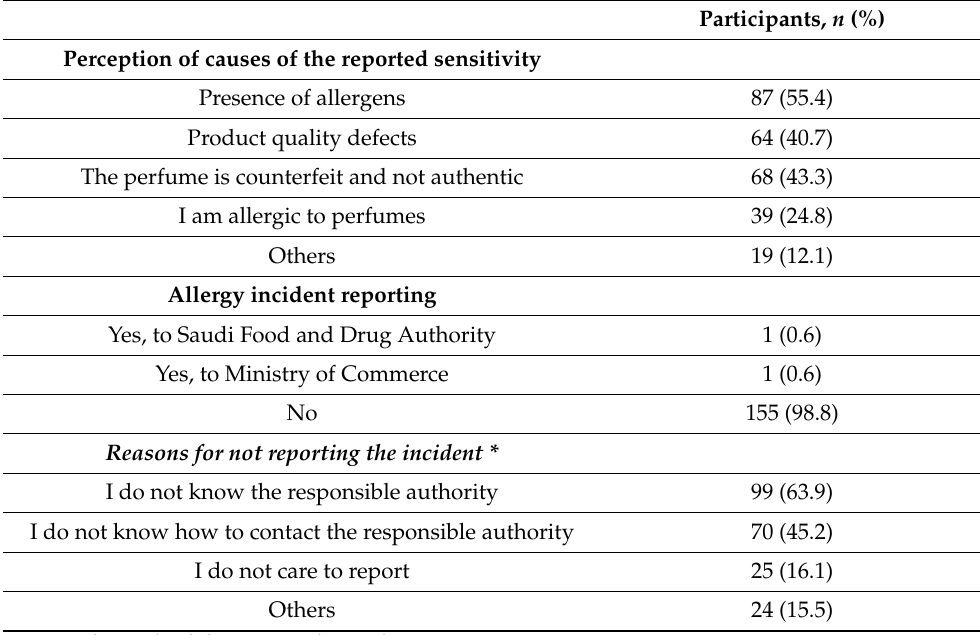
Table 5. Perfume allergy perceptions and reporting behavior among participants ( n =